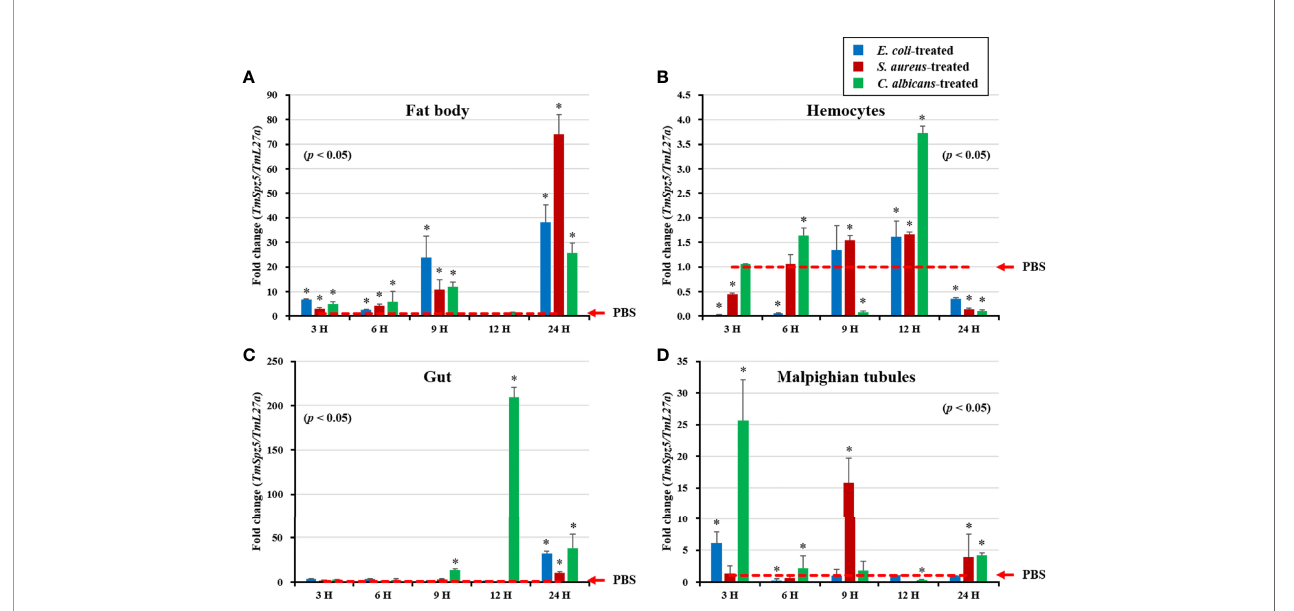
FIGURE 4 | Temporal expression patterns of TmSpz5 in immune-challenged T. molitor larvae. Levels of TmSpz5 mRNA in the fat bodies (A) , hemocytes (B) , gut (C) , and Malpighian tubules (D) were examined by qRT-PCR 3, 6, 9, 12, and 24 h after infection with E . coli (10 6 cells/µl) , S. aureus (10 6 cells/µl), and C . albicans (5 × 10 4 cells/µl). TmSpz5 expression was highly induced in the presence of C. albicans and S. aureus in various tissues. PBS was used as an injection control, and T. molitor 60S ribosomal protein 27a ( TmL27a ) primers were used as internal control (n = 3). Asterisks indicate signi fi cant differences between infected and PBS- injected larval groups by Student ’ s t -test ( p < 0.05). Vertical bars indicate means ± SD (n = 20).